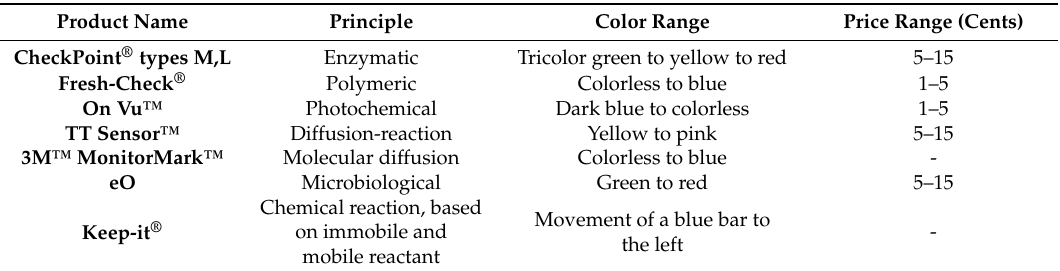
Table 1. Different examples and properties of commercially available TTIs (based on [36–38]).